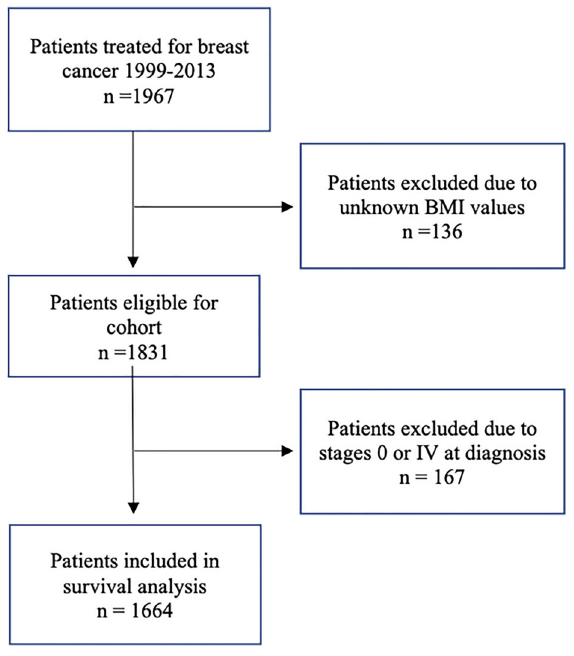
Figure 1. Flow diagram showing enrollment of women in the